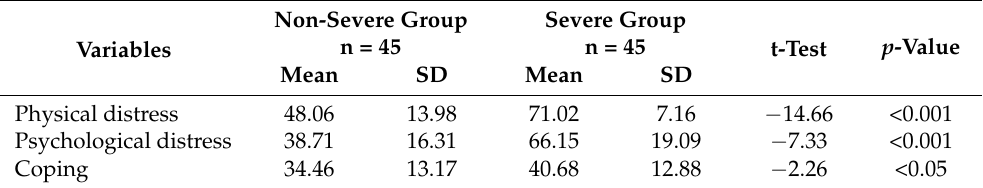
Table 3. Comparisons of mean difference of physical distress, psychological distress, and coping between non-severe and severe groups (n = 90).